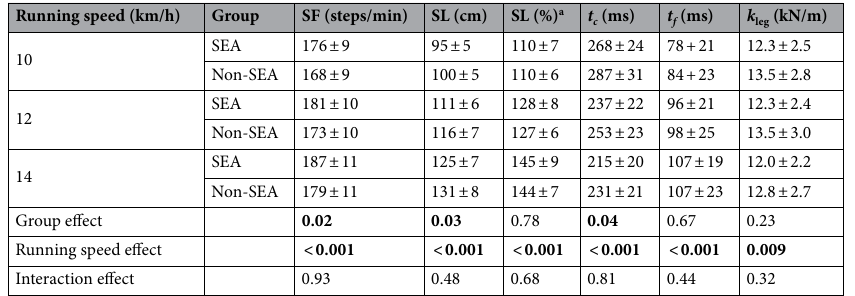
Table 2. Step frequency (SF), step length (SL), contact time ( t c ), flight time ( t f ), and spring-mass characteristics of the lower limb as given by leg stiffness ( k leg ) for South East Asian (SEA) and non-South East Asian (non-SEA) runners at endurance running speeds. Significant differences ( p ≤ 0.05) identified by linear mixed effects modelling are indicated in bold. SL was expressed as a percentage of participant’s leg length in addition to raw units. a Step length normalized to leg